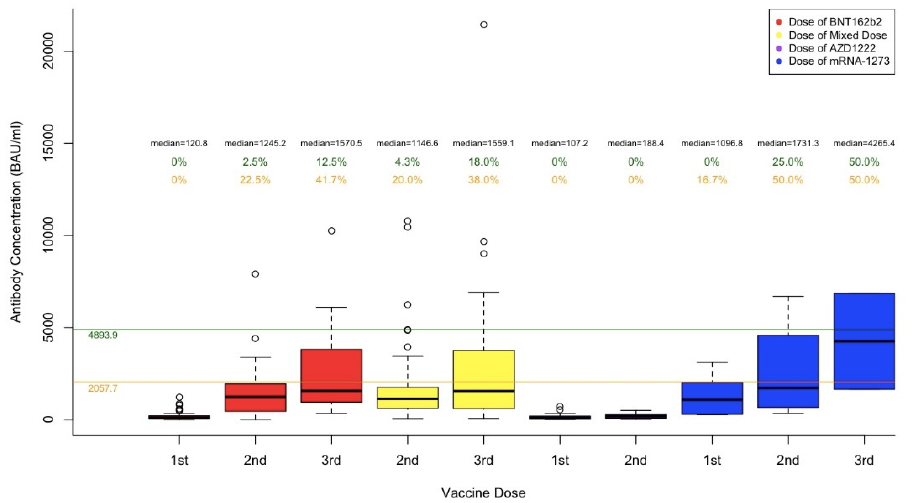
Figure 2. Serological Responses post 3 Doses and Comparison to Those in the Breakthrough Cases. The upper green line of 4893.9 BAU/mL is the highest antibody concentration prior to a known breakthrough infection. The lower orange line of 2057.7 BAU/mL is the average of antibody concentrations in seven infections confirmed by WGS. The percentages shown in green represent the percentage of antibody concentration that is above 4893.9 BAU/mL per each dose of each vaccine type, whereas the percentages in orange represent those above 2057.7